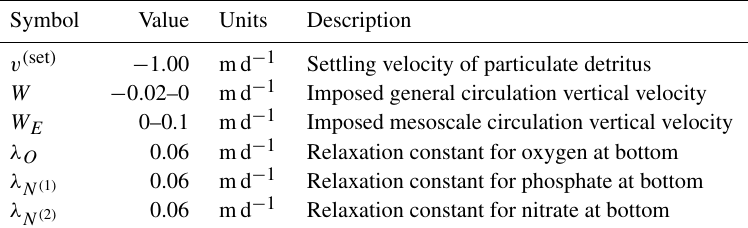
Relaxation constant for nitrate at bottom